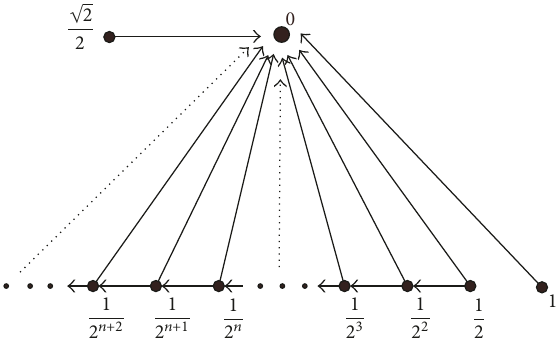
Figure 1: Graph 𝐺 (the loops and the isolated vertices are not